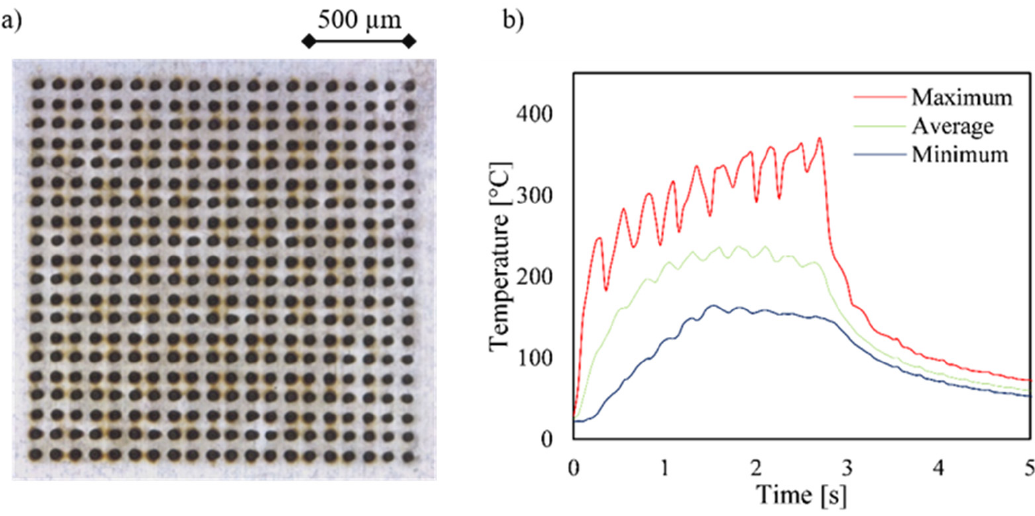
Figure 6. The microscope image ( a ) and the temperature plots ( b ) of a 20 × 20 array with 100 µm separation distance taken with a thermal imaging camera. The drilling process, with the optimized drilling sequence, using a 2 × 2 beam splitter and a power of 2.3 W with a repetition rate of 60 kHz was corrected with delays between the holes to increase the total process time by 25%.